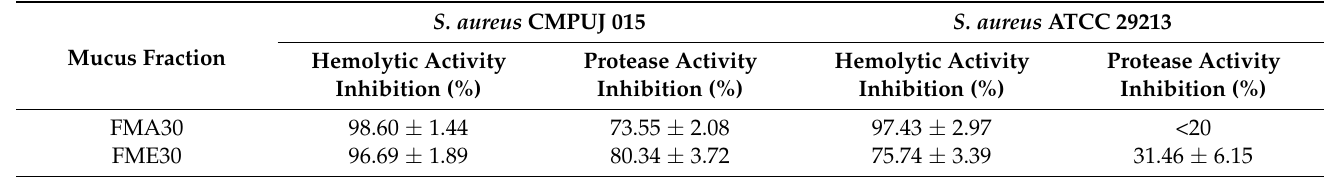
Table 3. Inhibition of hemolysin and protease production by S. aureus strains.